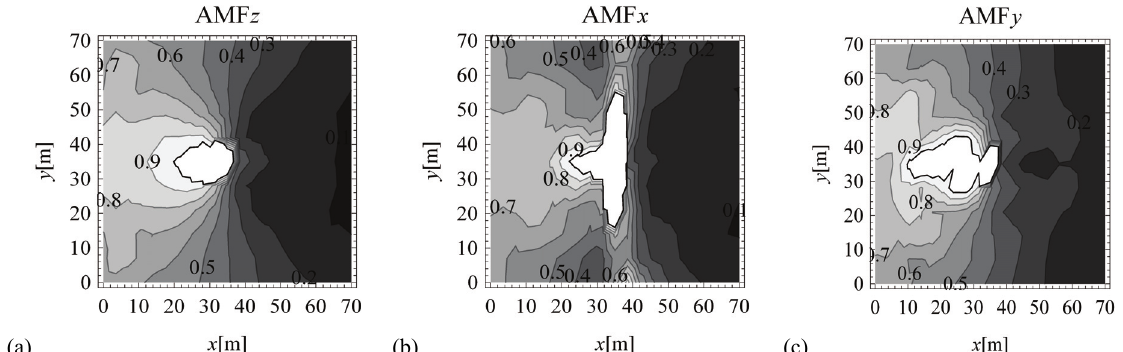
Fig. 5. AMF for the analyzed domain with the three displacement components for the points located on the ground surface, r = 2 m; plot range: 0 < AMF < 1; (a) displacement component in the z -direction, (b) displacement component in the x -direction,